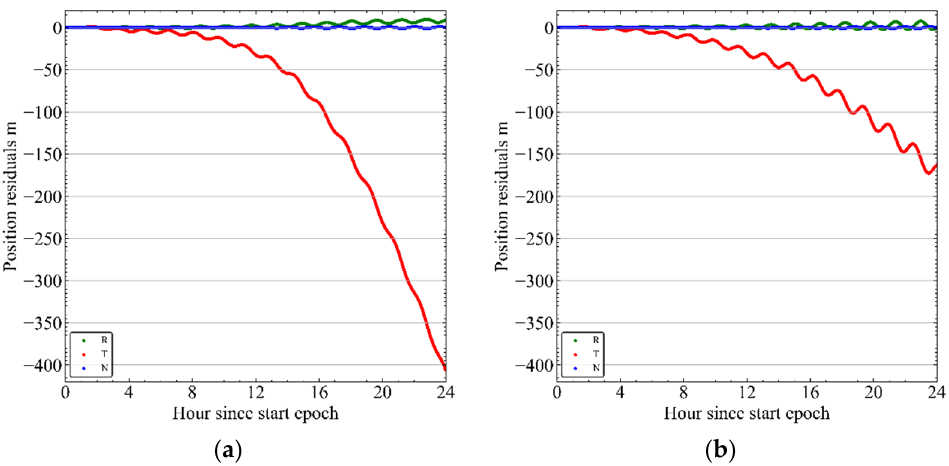
Figure 12. At high magnetic activities, orbit propagation error magnitudes without ( a ) and with ( b ) calibration of the derived densities. R is the radial direction, T is the along-track direction, and N is the cross-track direction. Table 2. Comparison of the derived density and model density of 24 h orbit propagation of the 3DRMS without and with geomagnetic storms.